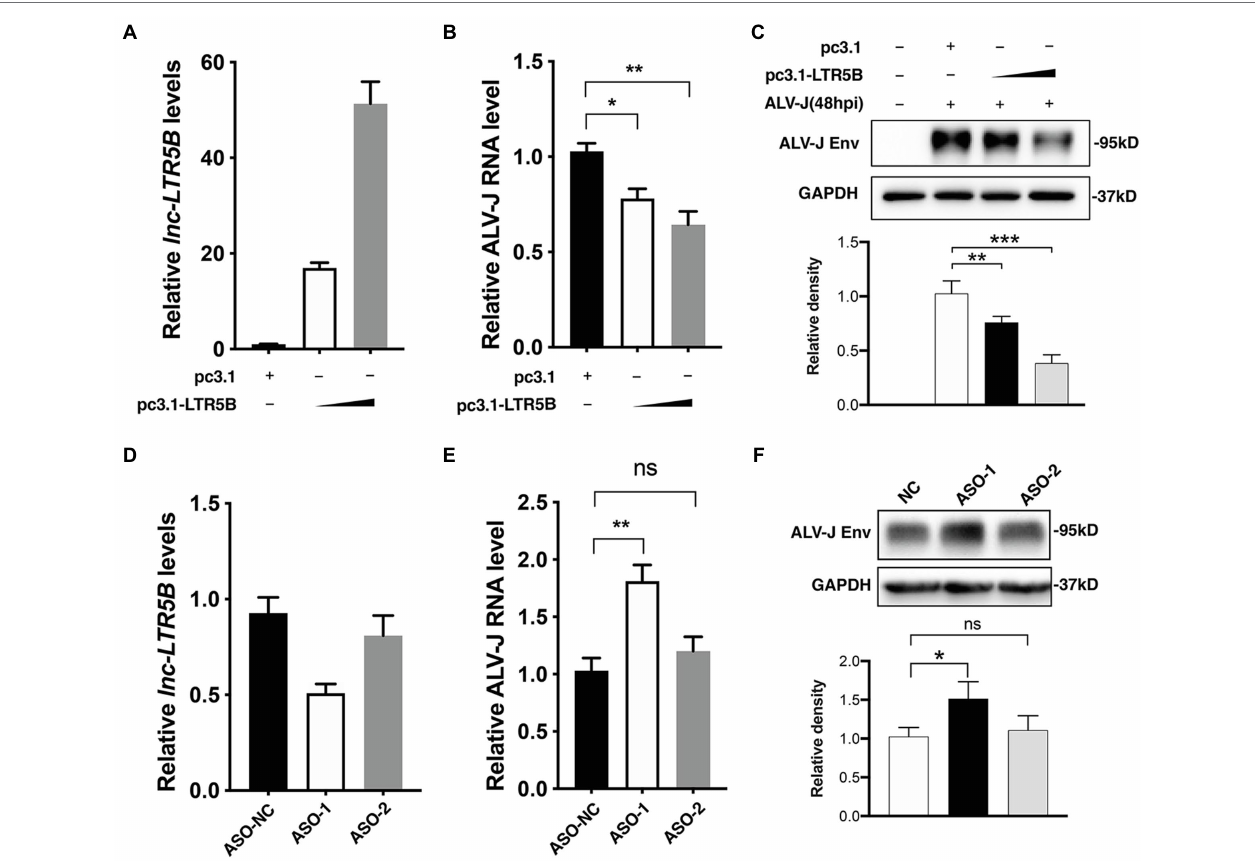
FIGURE 3 | lnc-LTR5B restricts ALV-J replication in DF-1 cells. (A-C) Overexpression of lnc-LTR5B suppressed ALV-J production. DF-1 cells were transfected with increasing amounts of pcDNA3.1-lnc-LTR5B or control pcDNA3.1 for 12 h, followed by infection with ALV-J (MOI = 0.5). Forty-eight hours post-infection, cells were harvested, and the level of lnc-LTR5B (A) and viral RNA (B) was measured by qRT-PCR. (C) ALV-J Env was measured by western blotting (top), and the density of each band was analyzed using Image J software. (bottom). (D-F) Knockdown of lnc-LTR5B in DF-1 cells promoted ALV-J production. DF-1 cells were transfected with either negative control ASO (ASO-NC) or ASO against lnc-LTR5B (50 nM) for 36 h. (D) The levels of lnc-LTR5B were quantified by qRT-PCR to examine the silencing efficiency. The cells transfected with ASO were then infected with ALV-J (MOI = 0.5) for 36 h. (E) The viral RNA was determined by qRT-PCR. (F) ALV-J Env was measured by western blotting (top), and the density of each band was quantified by ImageJ software. (bottom). Expression data were normalized to those of the negative vector or ASO-NC group. Data are presented as the mean ± SD, n = 3; * p < 0.05, ** p < 0.01, *** p < 0.001, ns, not significant (one-way